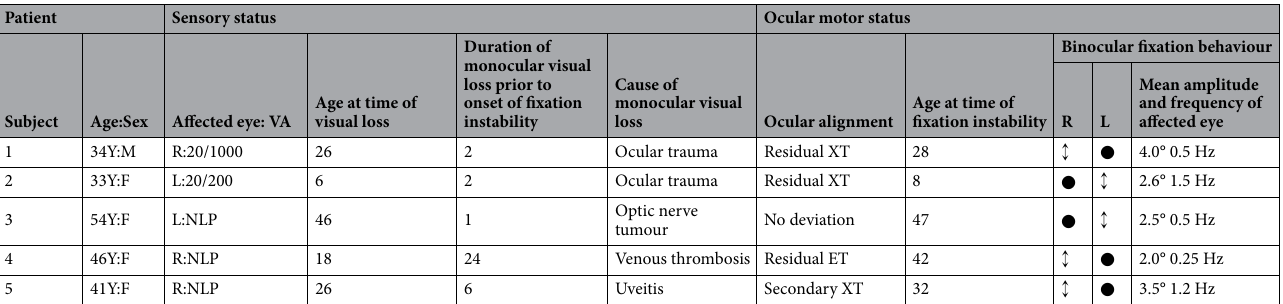
Table 1. Summary of the clinical findings from the 5 subjects. VA = visual acuity. M = male. F = female. R = right eye. L = left eye. NLP = no light perception. Age = age at the time of the final eye movement recording session in years. Residual tropia = a smaller deviation (in the same direction) following extra-ocular muscle surgery; secondary tropia = a strabismus secondary to a visual loss. ET = esotropia. XT = exotropia. ° = degrees. Hz = Hertz. = stable fixation. ↕ = vertical oscillation. Note: The fixation pictograms indicate fixation behaviour. Frequencies and amplitudes in the rightmost column were approximated directly from chart ● recordings by experienced oculomotor clinicians. All 5 subjects exhibited their oscillations for a minimum period of 4 years prior to the commencement of the